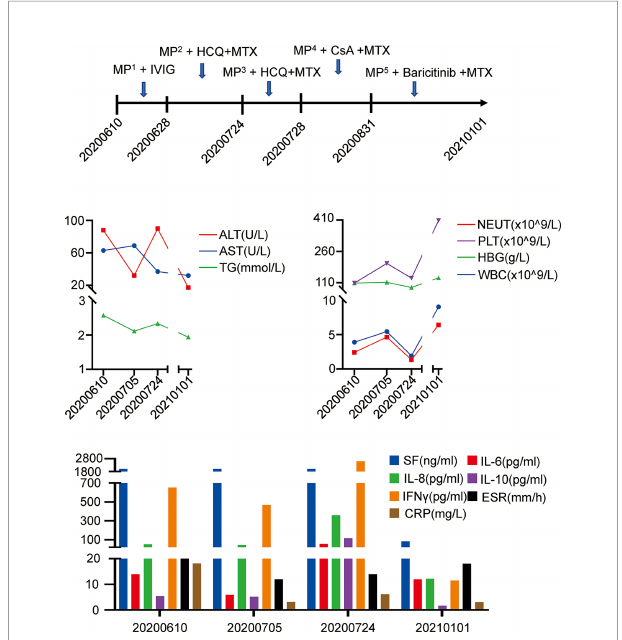
FIGURE 3 | Clinical course and laboratory examination. IVIG, immu- noglobulin. (MP 1 80-40mg daily, MP 2 60-28mg daily, MP 3 500-40mg daily, MP 4 500-20mg daily, MP 5 20-1mg